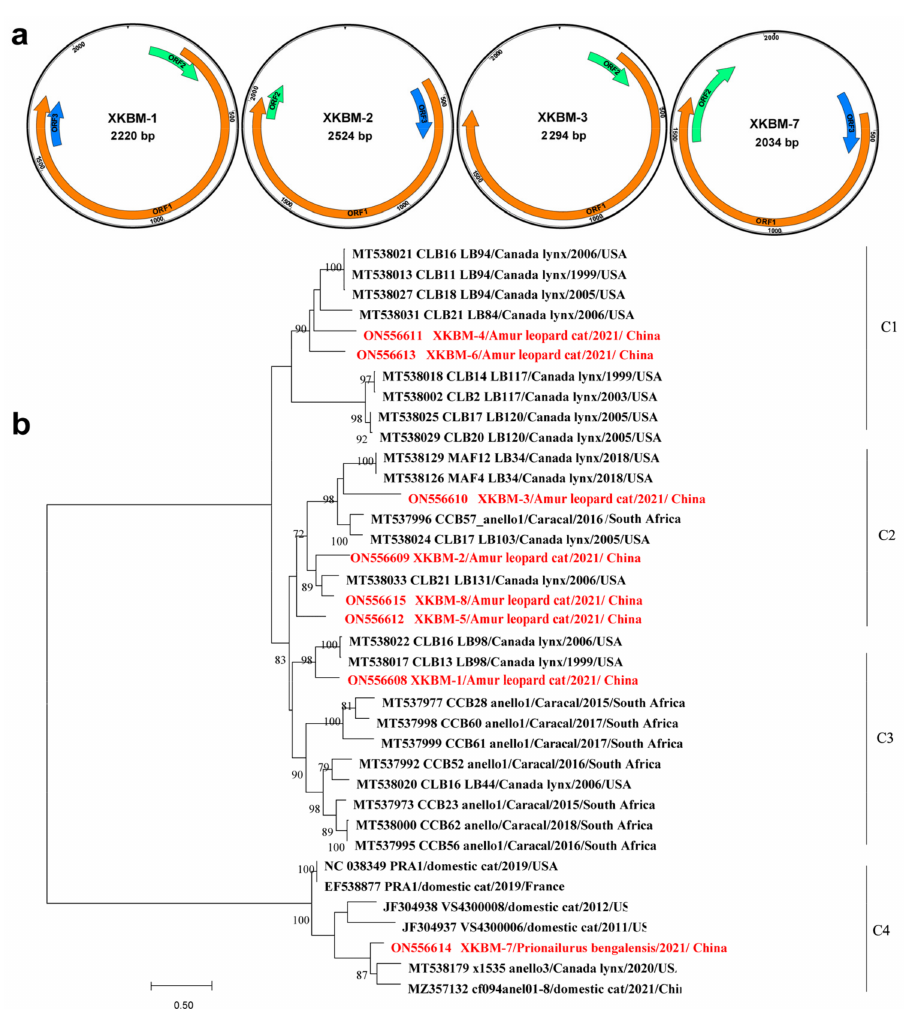
Figure 2. Genomic characterization of anelloviruses. ( a ) The genomic structures of four representative anelloviruses. The orange ORF represents ORF1; the green one, ORF2; the blue one, ORF3. ( b ) The phylogenetic analysis of ORF1 aa sequences. Viruses identified here are highlighted in red. Bootstrap values of ≥ 70 are shown next to